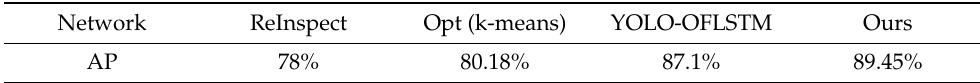
Table 3. Experimental results.